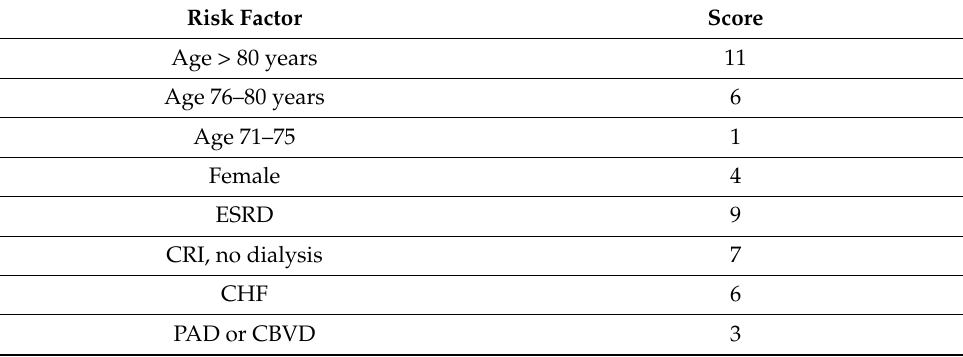
Table 1. Medicare aneurysm scoring